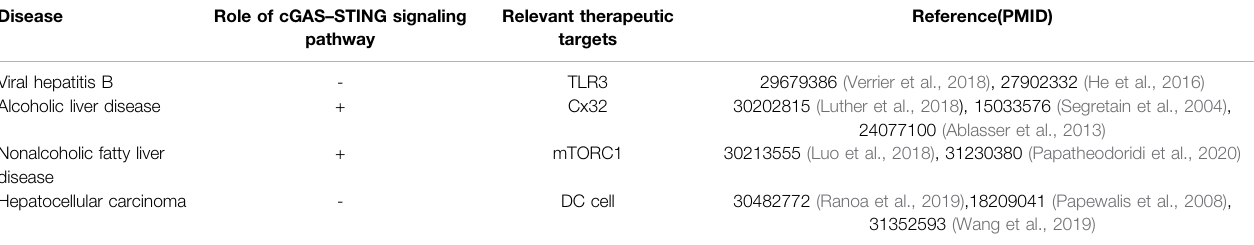
TABLE 1 | Role of cGAS – STING signaling pathway in liver disease and relevant therapeutic